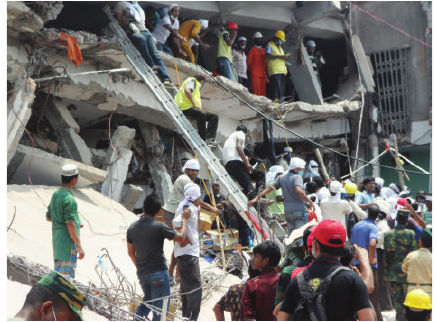
Figure 4: Rescue at Rana Plaza collapse.